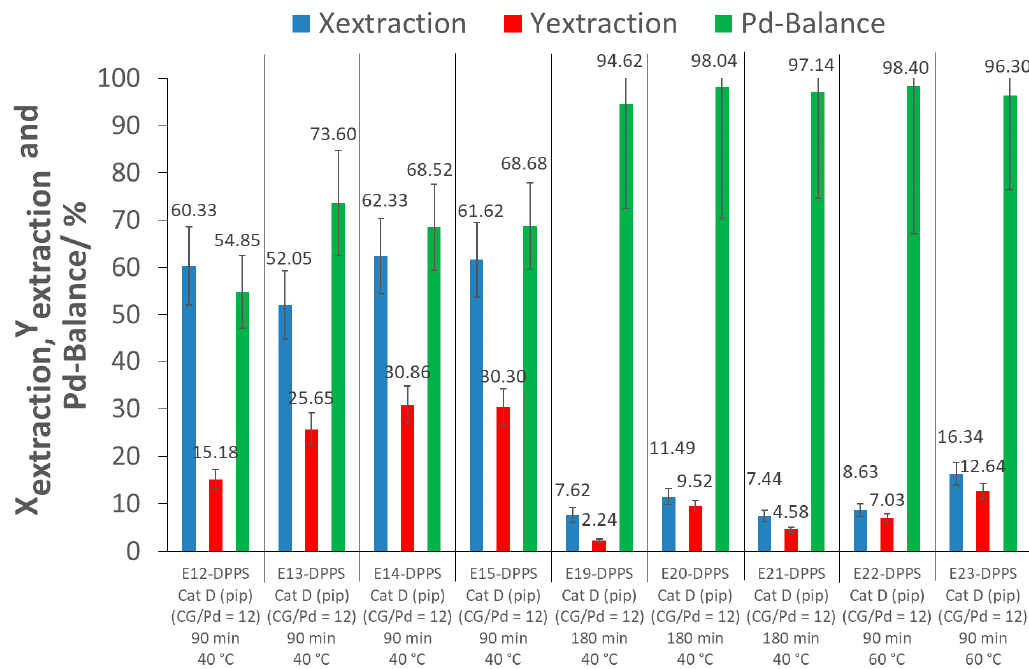
Figure 8. Results of the extractions of Pd with p(FDA- co -DPPS) at different extraction times and temperatures ((pip): piperidine; CG/Pd: Complexing group/Pd ratio; Ex-DPPS: Detailed investigation experiments).